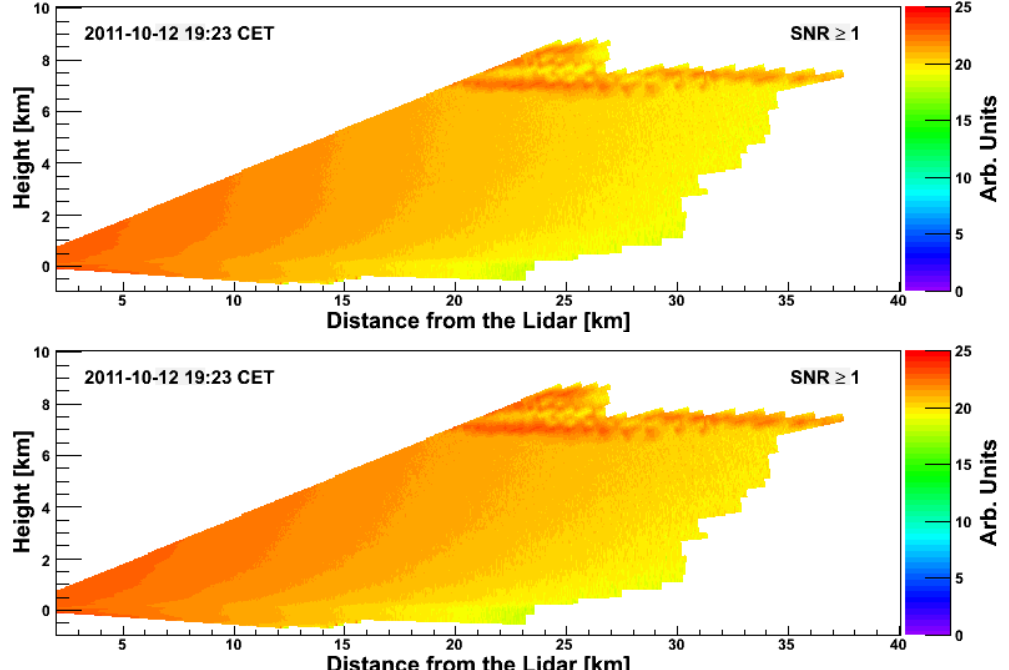
Figure 4. Effect of Rayleigh correction ( top , before; bottom , after) on a 2D RHI diagram to show the atmospheric conditions. The scan example was taken from the LiDAR-radiosonde measurements at 19:23 Central European Time (CET) on 12 October 2011. The height is given relative to the altitude of the LiDAR